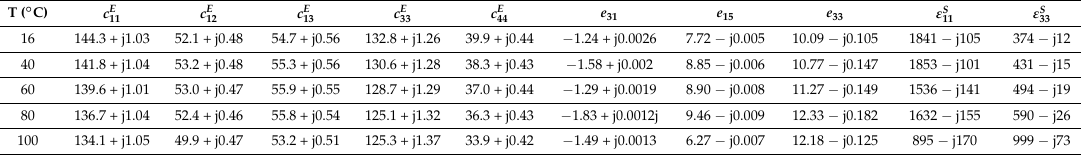
Elastic constants are in GPa, piezoelectric constants in C/m 2